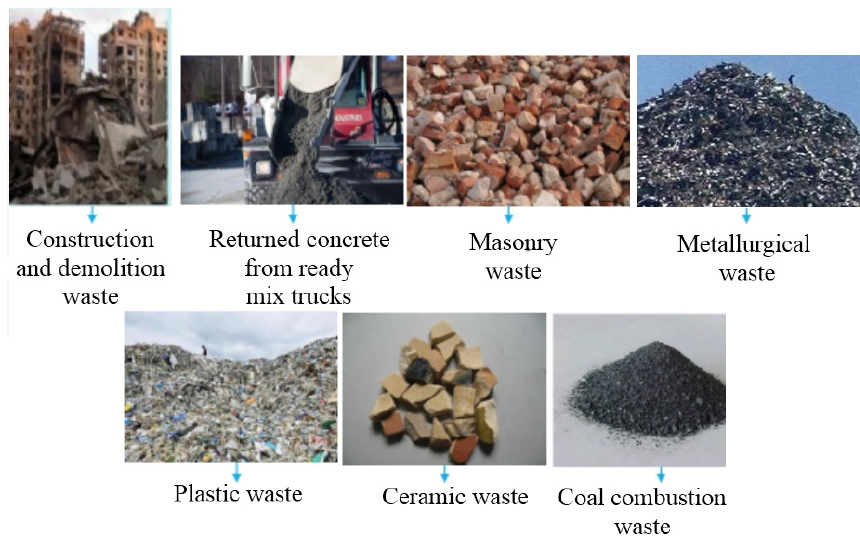
Figure 3. Typical recycled aggregates.